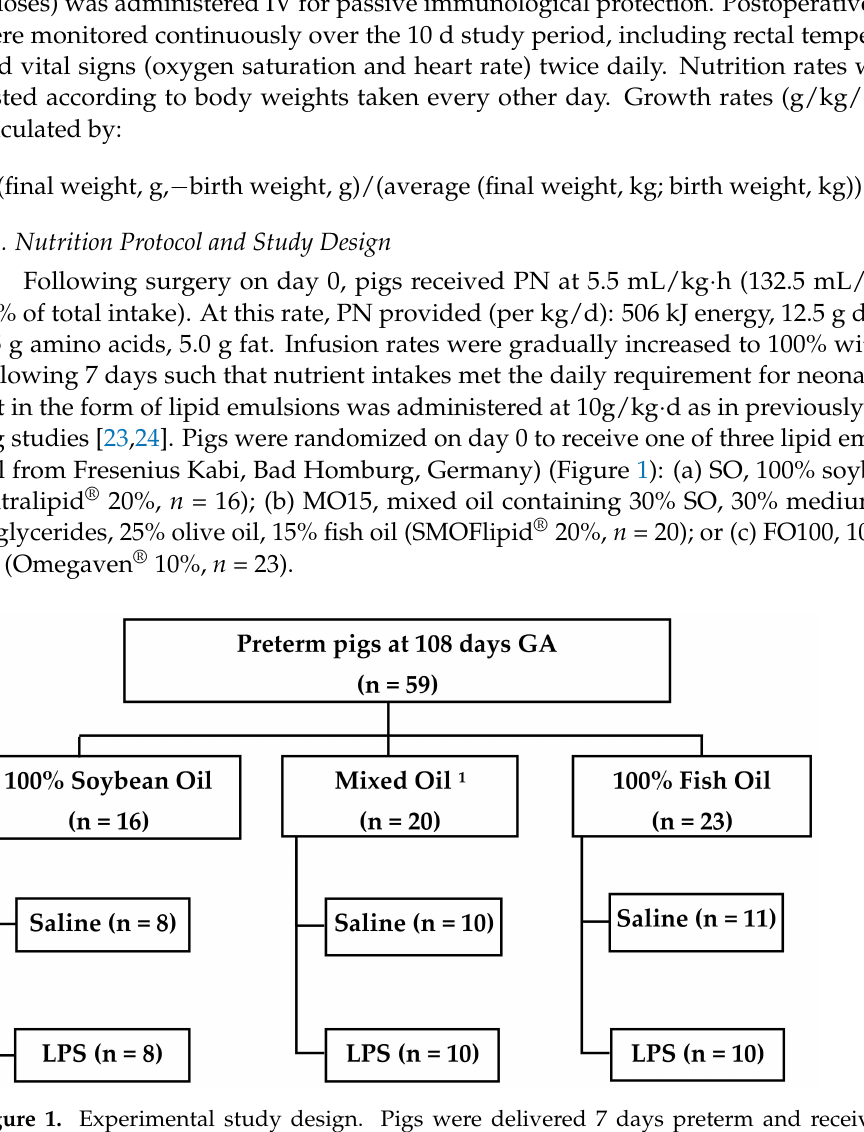
Figure 1. Experimental study design. Pigs were delivered 7 days preterm and received total parenteral nutrition for 11 days. On day 11, pigs received either LPS (lyophilized E. Coli ) or saline. 1 Mixed oil contains: 30% soybean oil, 30% medium chain triglycerides, 25% olive oil, 15% fish oil. GA, gestational age; LPS,